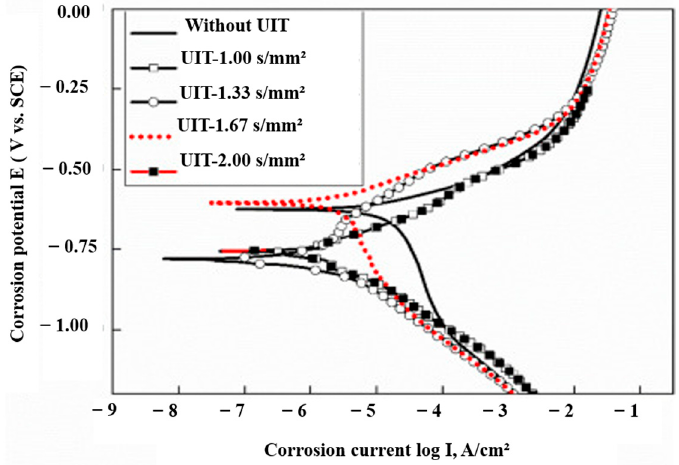
Figure 10. Polarization curves for specimens with different impact intensities. Reproduced with permission from [92]. Copyright Elsevier, 2021.